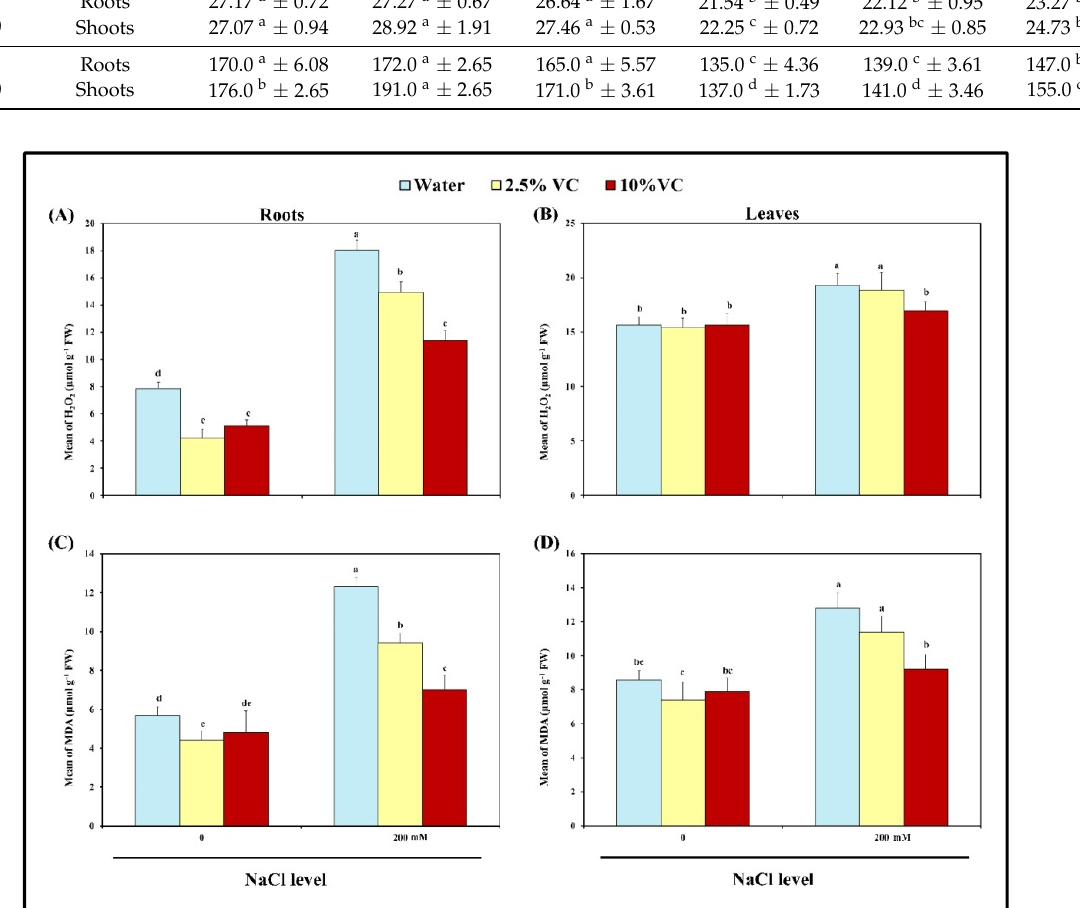
Figure 1. Effects of vermicompost with 2.5 and 10 percentages on hydrogen peroxide ( A and B ) and malondialdehyde ( C and D ) in the roots and leaves of broad bean plants exposed to 0 and 200 mM NaCl after 30 days of cultivation. Bars represent means and standard deviation of three independent replications ( n = 3). Different alphabetical letters indicate significant differences among the treatments at p < 0.05, according to a Duncan’s multiple range test.